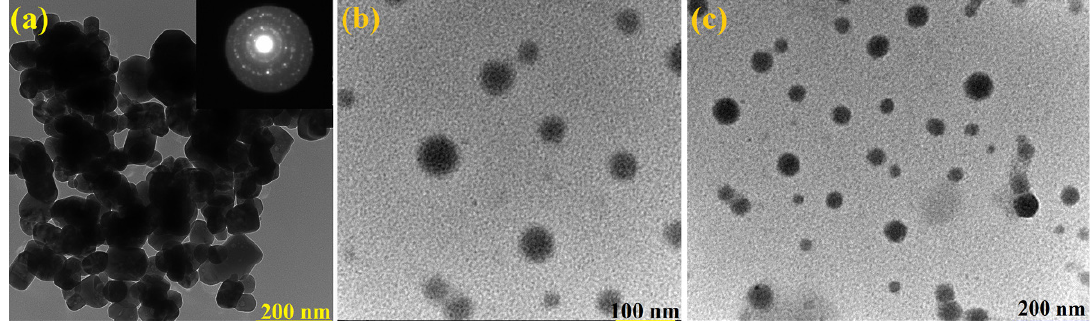
Figure 6. The TEM images of ZnO nanoparticles (a), ZnO-PCEMA-Br-2 (b) and ZnO-PCEMA- b -PEGMA-Br-2 polymer (c) deposited from THF Table 3. The characteristics of the surface roughness parameters including root mean square (Sq), average roughness (Sa) and average height (Ha) from the histogram of the studied samples. Sample